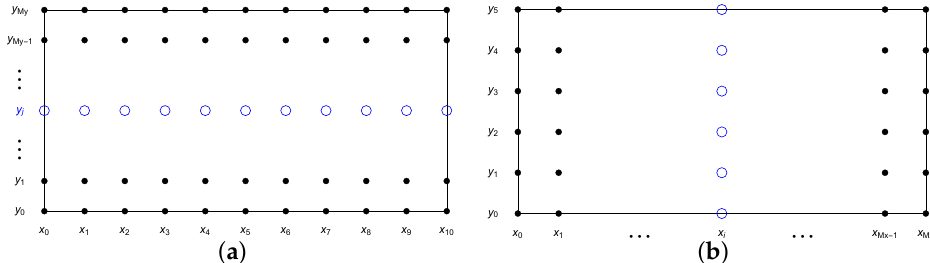
Figure 1. Numerical solution in the horizontal direction (for a fixed node y j ) ( a ) and the vertical direction (for a fixed node x i ) ( b